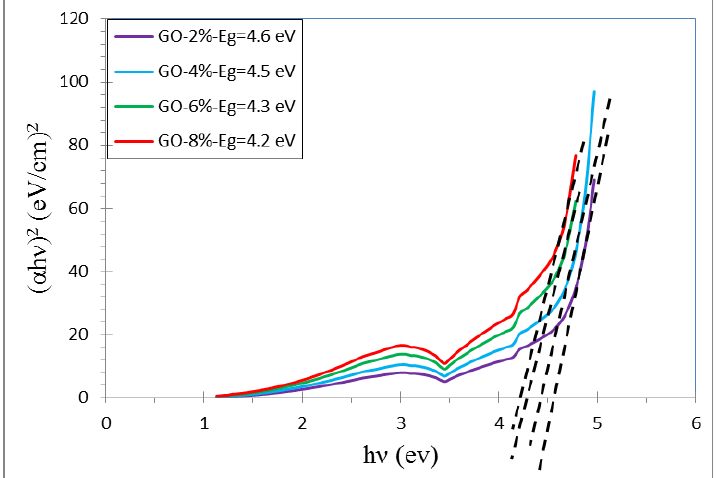
Fig.7: The optical band gap for glass for different doping concentrations of graphene oxide thin films (2, 4, 6 and 8) % wt.